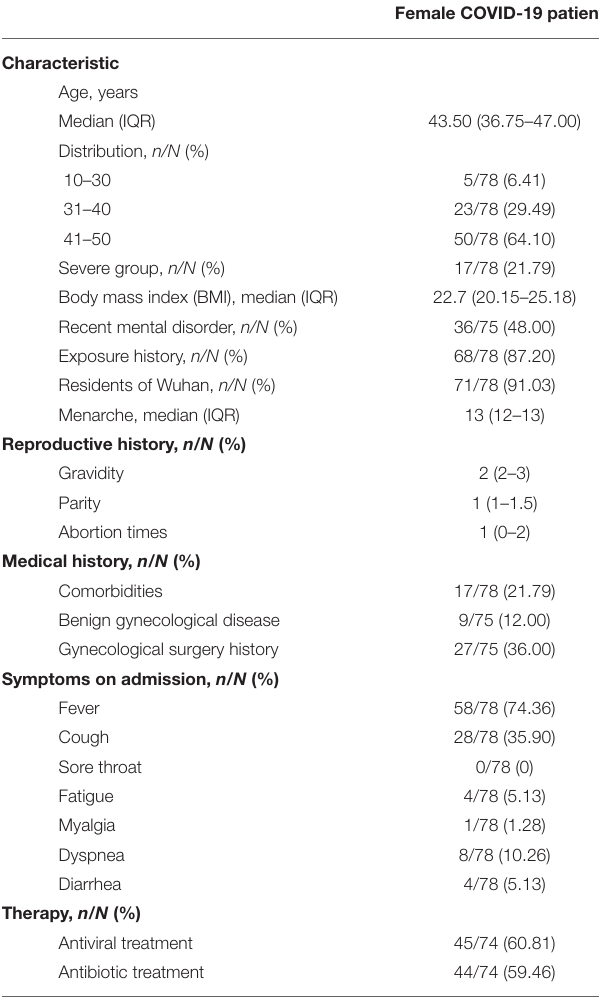
TABLE 1 | Baseline and clinical characteristics of the female patients with